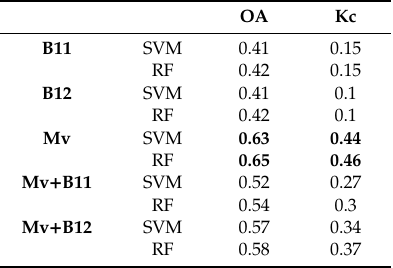
Table 5. Overall accuracy (OA) and kappa Coe ffi cient (Kc) results derived from the confusion matrix, using three-fold cross-validation with the SVM and RF classifiers, based on optical data (B11 and B12), soil moisture products, and a combination of soil moisture and optical